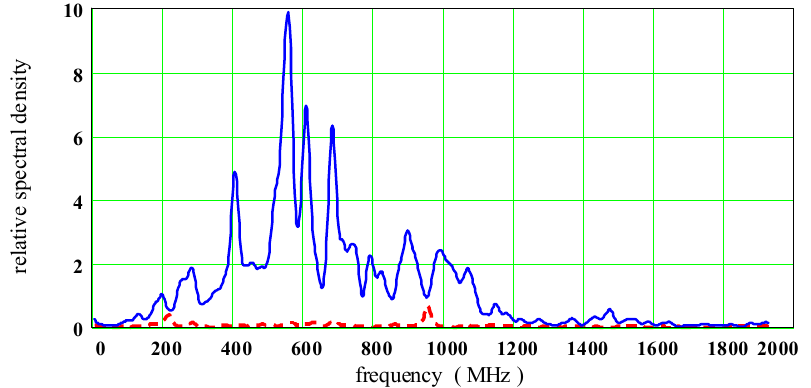
Figure 23. ( a ) A 100 ns portion of the S2 UHF signal taken from the signal in Figure 20. ( b ) A portion of S2 background signal selected from the same record.